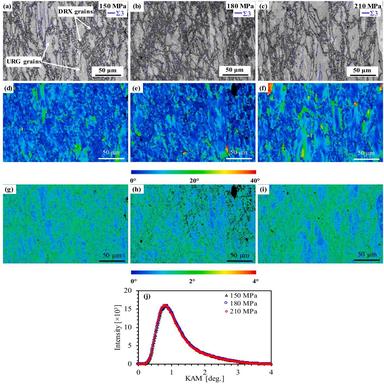
(a-c) Pattern quality maps superimposed with grain and twin boundaries, (d-f) GAM, and (g-i) KAM of crept specimens with different stress levels, and (j) KAM histograms.